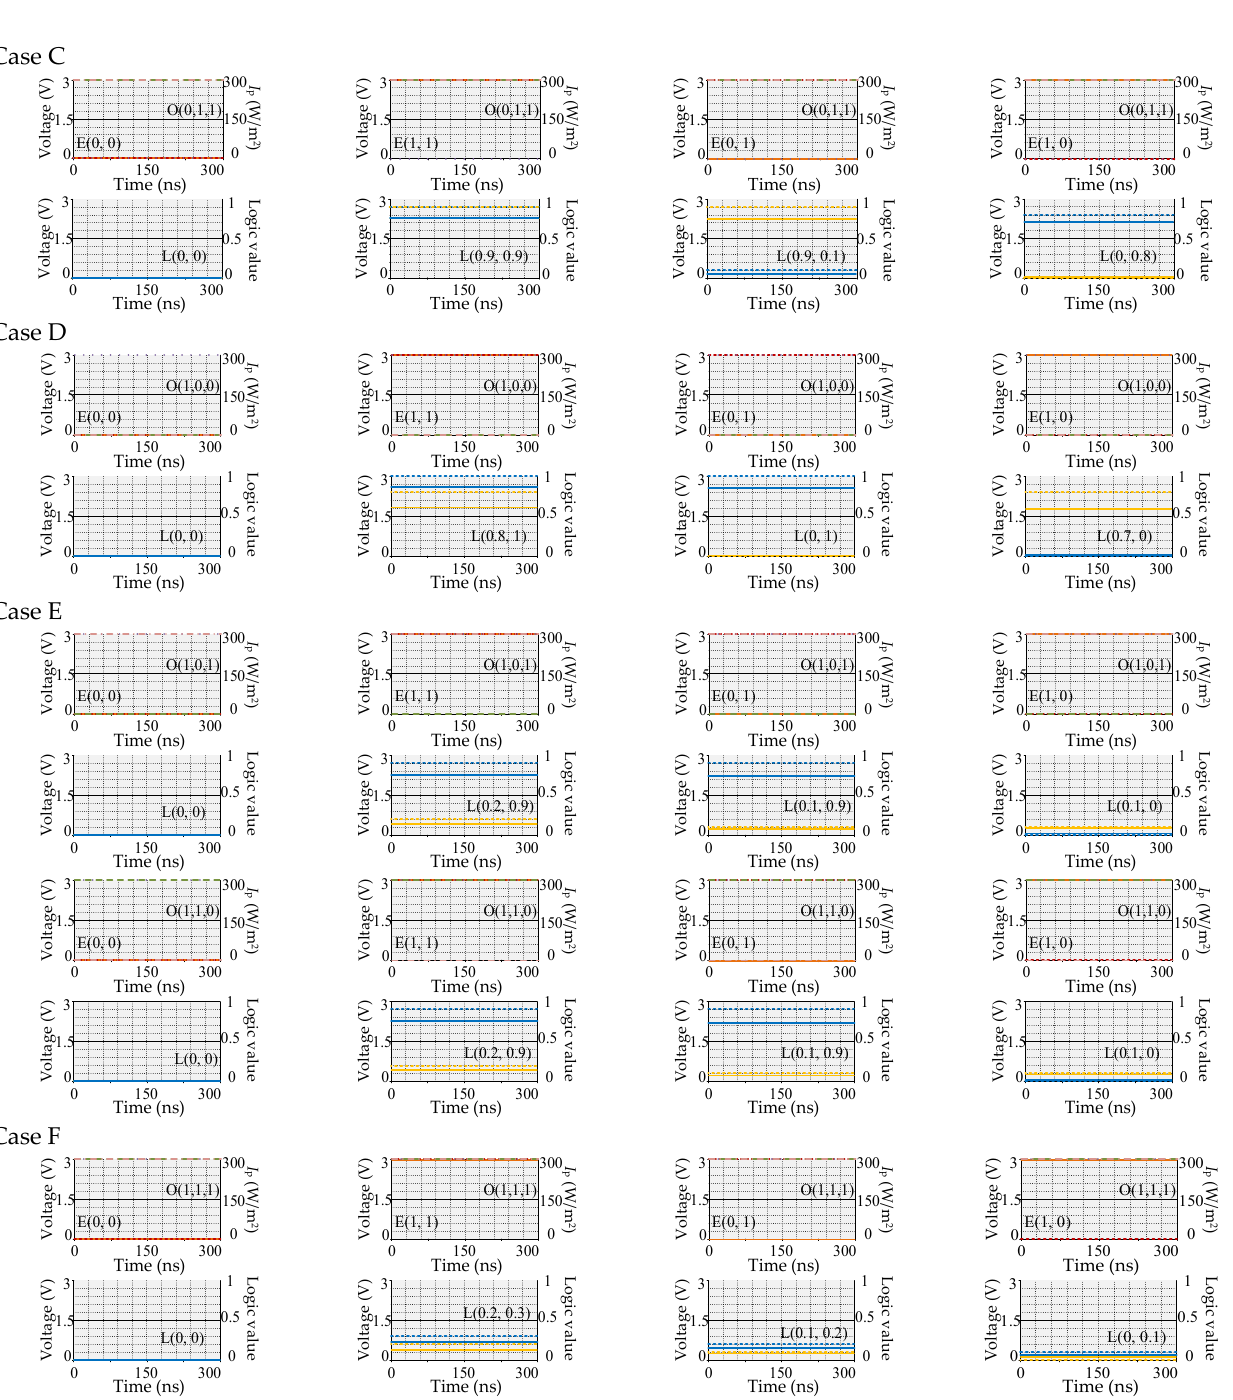
Figure 8. The simulation results of multi-valued logic circuit (including states I and II ).